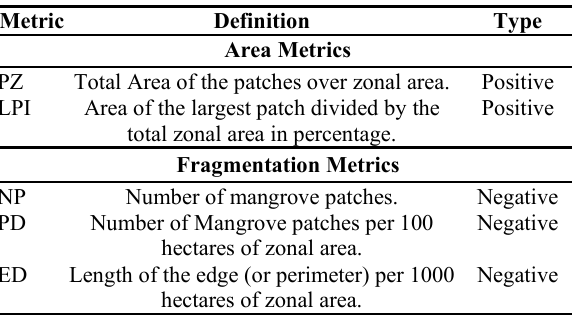
Table 1. Selected landscape Metrics for fragmentation